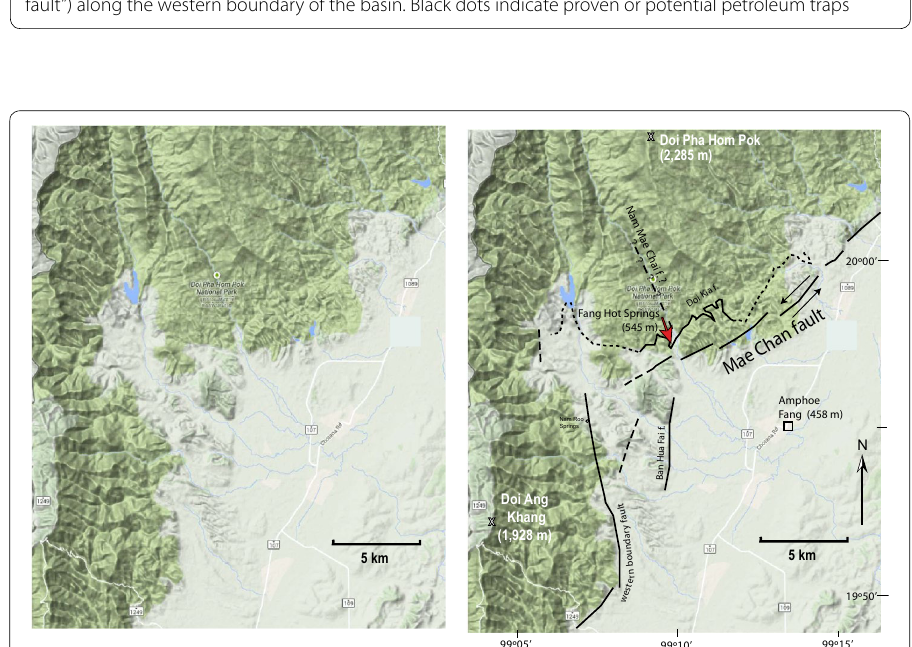
Fig. 6 Relief map of the northern Fang basin showing physiographic expression of the late Cenozoic faults